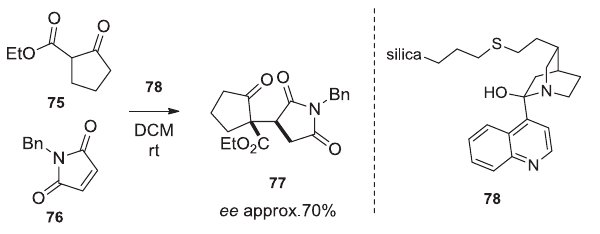
Figure 19. Enantioselective Michael addition, from Ref.